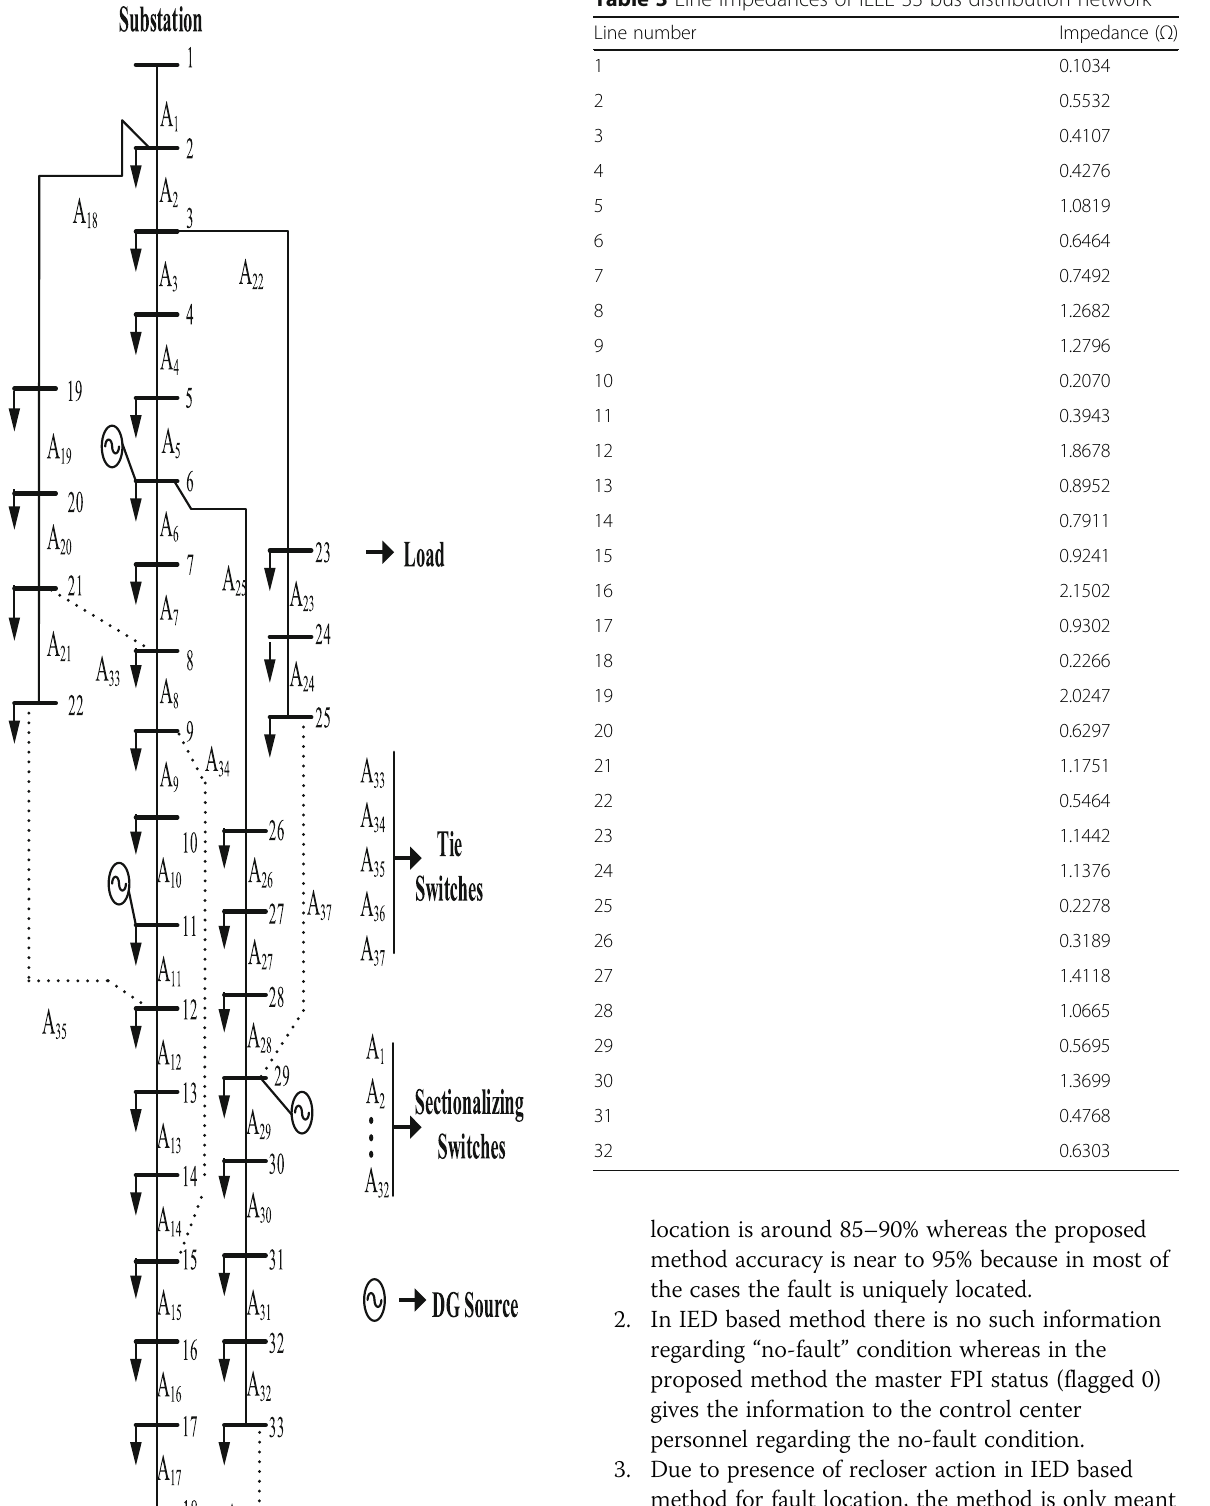
Table 3 Line impedances of IEEE 33 bus distribution